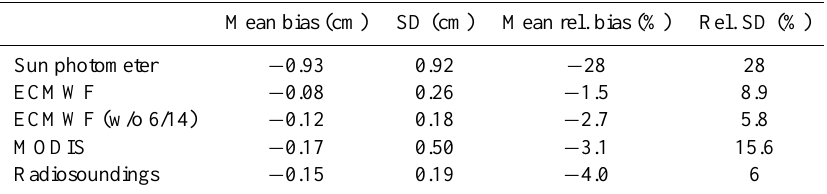
Table 2. Statistics for the comparison between various integrated water vapour content retrievals and the lidar (simultaneous measurements within ±